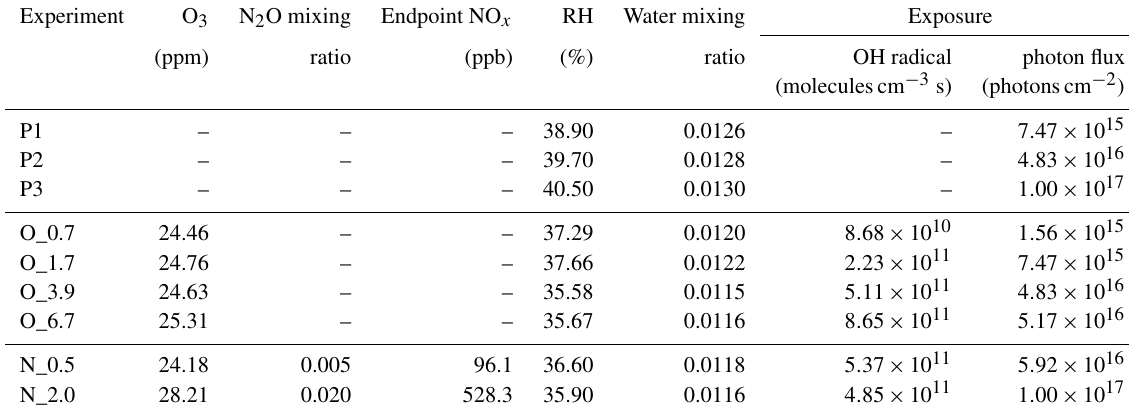
Table 1. Experimental conditions for tar ball particles photochemical oxidation. Experiment O 3 N 2 O mixing Endpoint NO x RH Water mixing Exposure (ppm) ratio (ppb) (%) ratio OH radical photon flux (moleculescm − 3 s) (photonscm − 2 ) P1 – – – 38.90 0.0126 – 7 . 47 × 10 15 P2 – – – 39.70 0.0128 – 4 . 83 × 10 16 P3 – – – 40.50 0.0130 – 1 . 00 × 10 17 O_0.7 24.46 – – 37.29 0.0120 8 . 68 × 10 10 1 . 56 × 10 15 O_1.7 24.76 – – 37.66 0.0122 2 . 23 × 10 11 7 . 47 × 10 15 O_3.9 24.63 – – 35.58 0.0115 O_6.7 25.31 – – 35.67 0.0116 N_0.5 24.18 0.005 96.1 36.60 0.0118 N_2.0 28.21 0.020 528.3